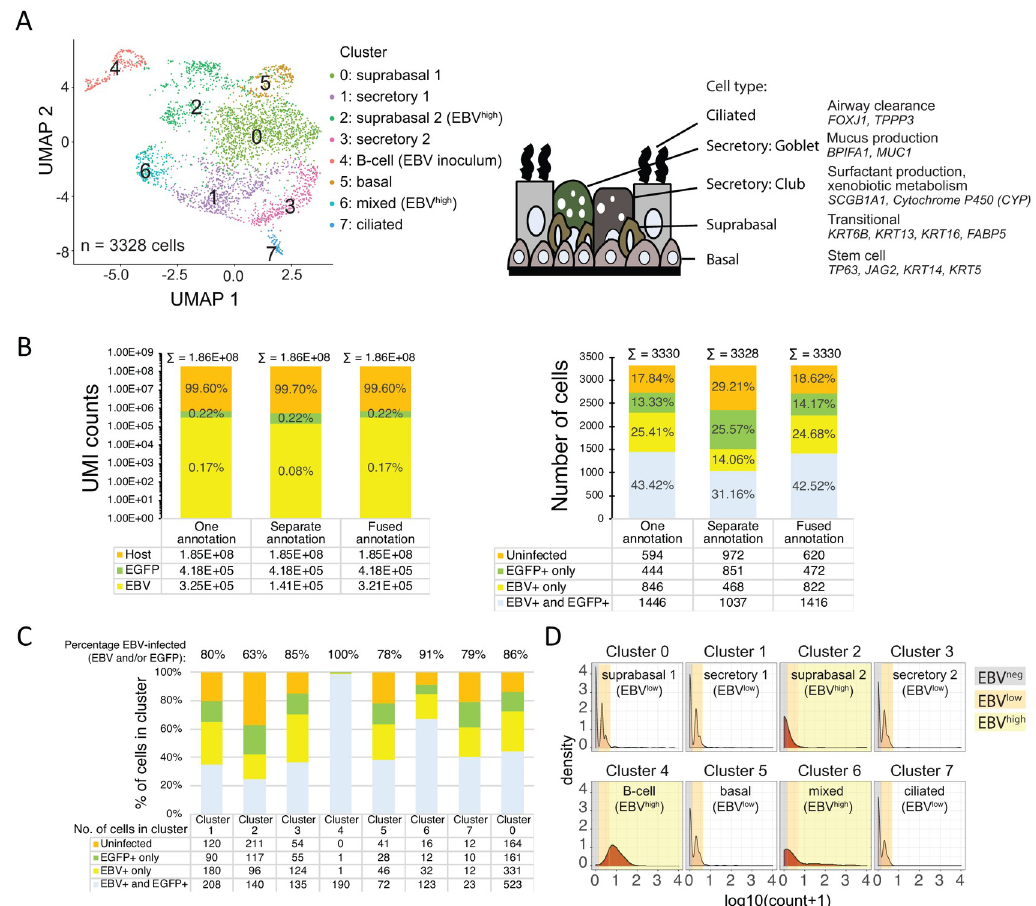
Fig 5. Identification of EBV-infected cell types from scRNA-seq performed on a pseudo-ALI culture from donor no. 4. (A) Uniform Manifold Approximation and Projection (UMAP) plots displaying the major cell clusters and assigned identity from host marker genes. Schematic displays the cell types in the pseudostratified nasal epithelium that are represented in the cell clusters. (B) Comparison of alignment methods against different EBV genome annotations by UMI counts and numbers of cells. (C) The percentage of EBV-infected cells is displayed for each cluster. Shown are the results from alignment to the fused annotation EBV genome, (D) Density plots of log10 transformed pseudocount (UMI count+1) for EBV reads against normalized cell numbers displayed for each cell cluster. Cell numbers are normalized for the total number of cells in each cluster. Cells are grouped by EBV negative , EBV low and EBV high populations designated by reads aligning to the EBV genome. Density plots with a similar profile are similarly colored. Where applicable (B-C) cells with reads aligning to the EGFP gene is also shown.